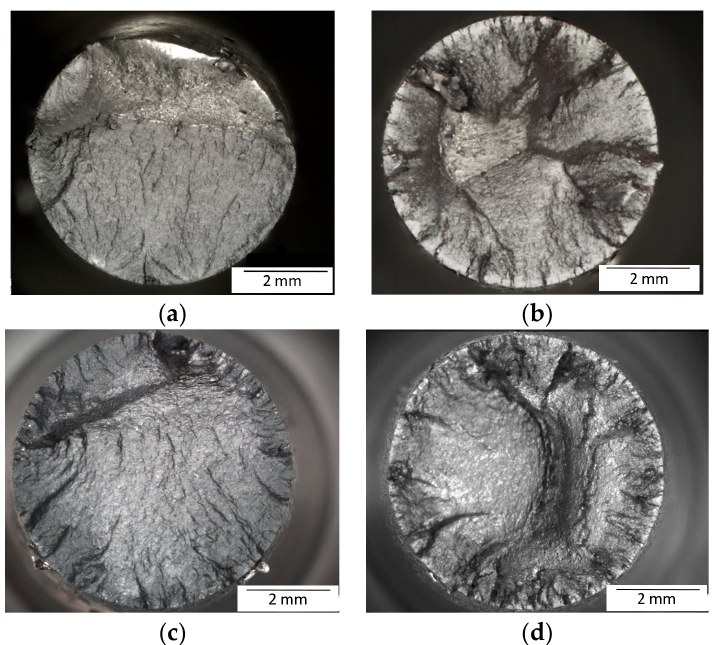
Figure 15. Optical micrographs of the fractured surfaces of the different LCF- and RF-tests, at 620 °C ( a ) LCF ±0.2%, ( b ) RF ±0.2%, ( c ) LCF ±0.4%, and ( d ) RF ±0,4%.